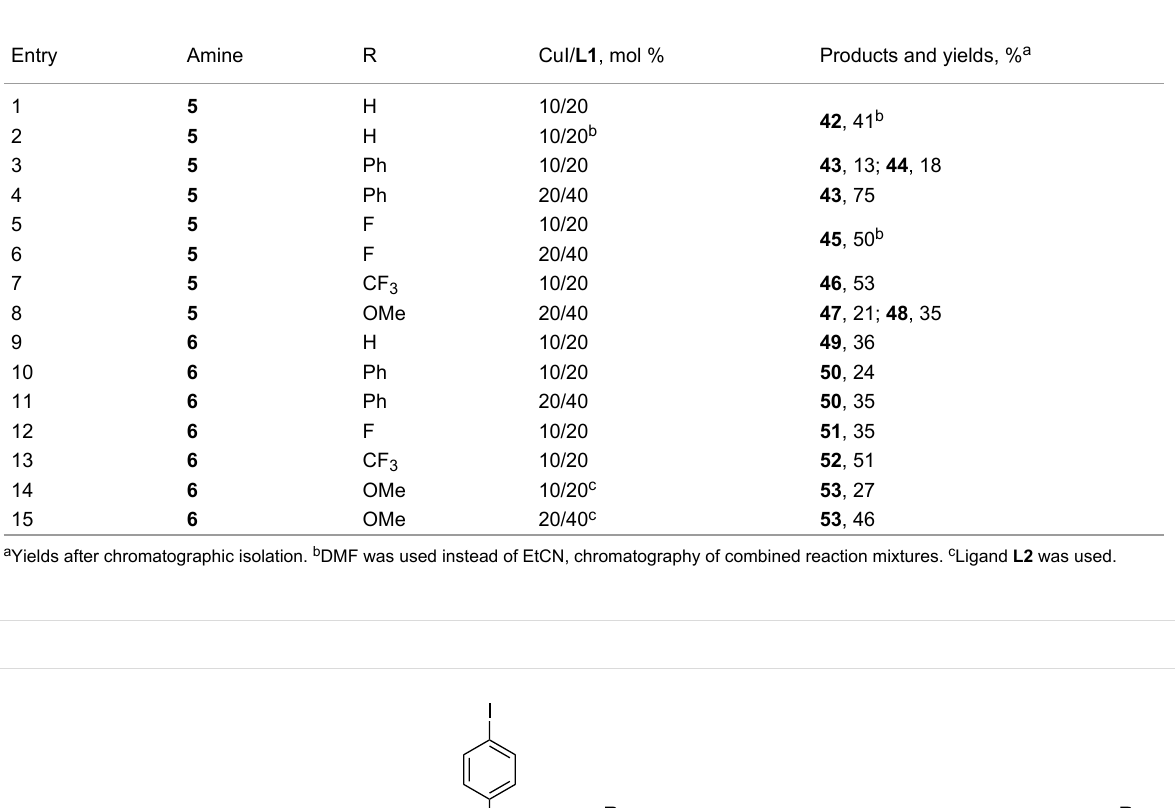
Table 4: Arylation of the triamines 5 and 6 .